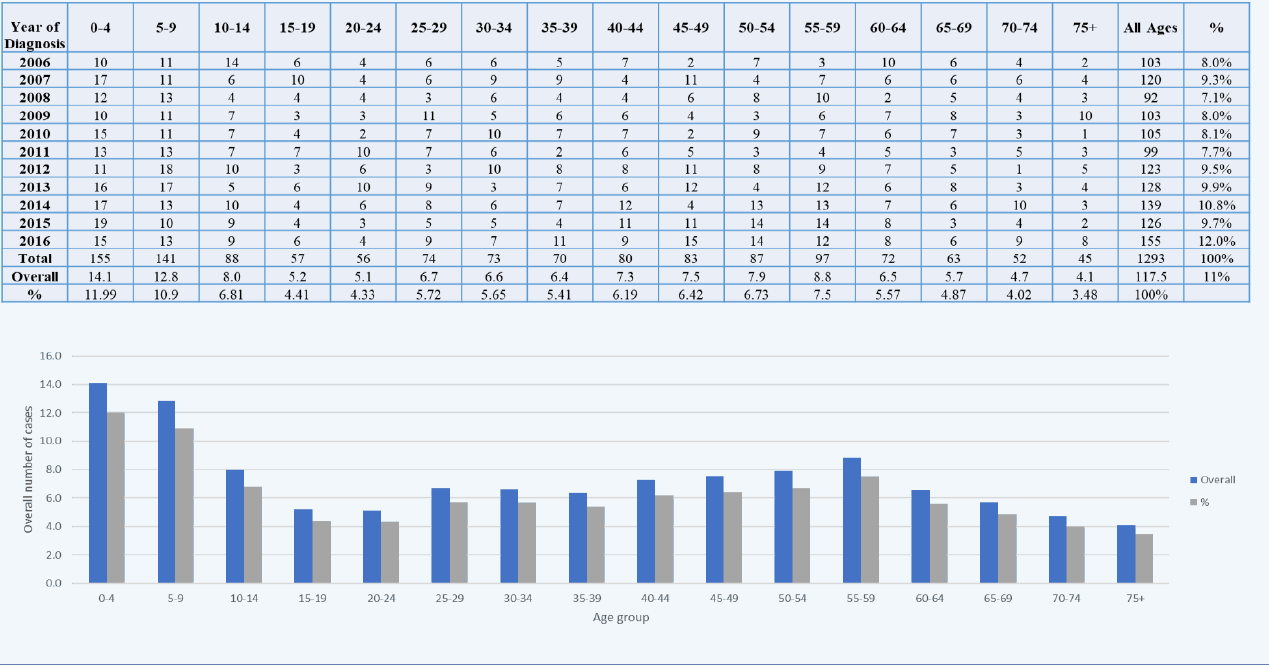
Figure 7. Numbers and percentages of brain tumors in females from 2006 to